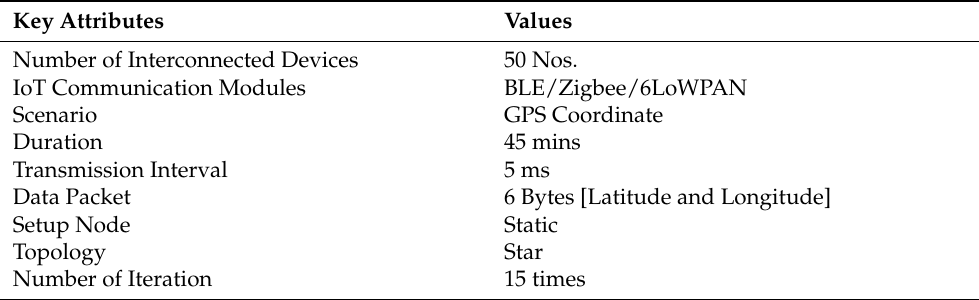
Table 4. Key Attributes of the Networking System.